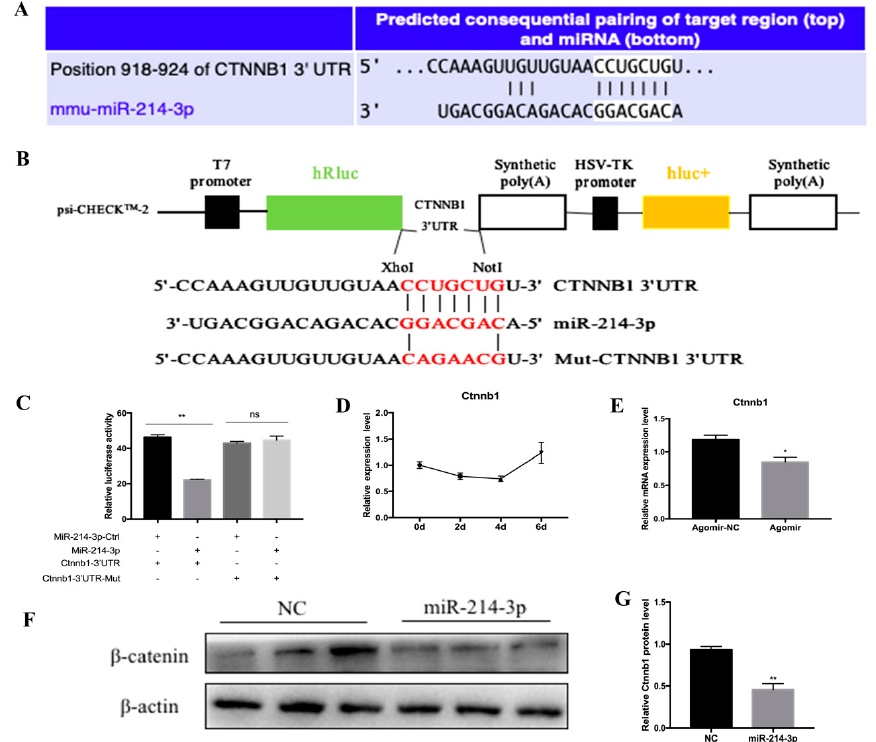
Figure 7. MiR-214-3p can target Ctnnb1 during 3T3-L1 preadipocyte differentiation. ( A ) Ctnnb1 is a direct target gene of miR-214-3p; ( B ) Schematic diagram of the dual luciferase reporter psi-CHECK 2.0-Ctnnb1 3’UTR; ( C ) Dual luciferase assay was performed by co-transfection of miR-214-3p agomir and wild-type vectors or mutant vectors. Relative luciferase activity was represented by Renilla Luciferase / Firefly Luciferase (RLUC / FLUC); ( D ) Expression profile of Ctnnb1 during adipogenic differentiation; ( E ) The relative Ctnnb1 mRNA expression levels after treatment with the miR-214-3p agomir; ( F ) Western blot analysis of Ctnnb1 protein expression after transfection with the miR-214-3p agomir at six days of adipogenic differentiation; ( G ) The quantification of β -catenin protein levels. Results are represented as mean ± SEM. n = 3. * p < 0.05; ** p < 0.01, vs. NC.